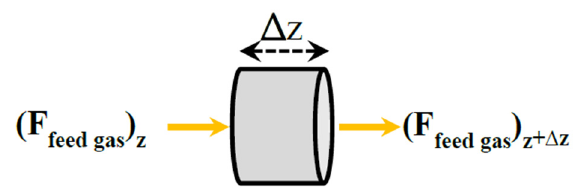
Figure 2. The proposed system for pure hydrogen producing in an on-board engine.